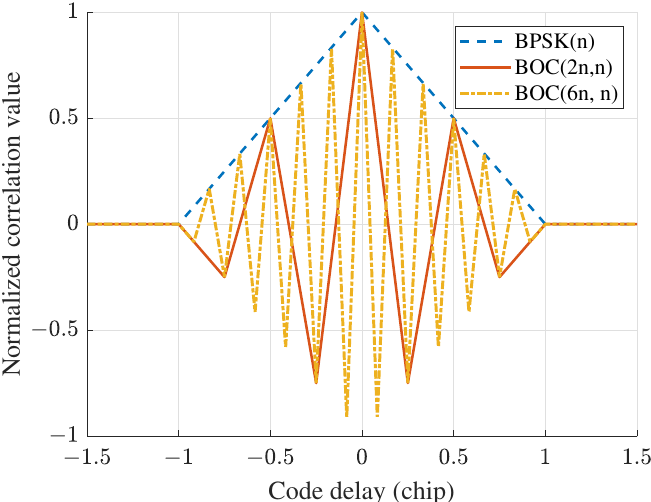
Figure 1. Normalized auto-correlation functions of BPSK(n), BOC(2n,n), and BOC(6n,n)